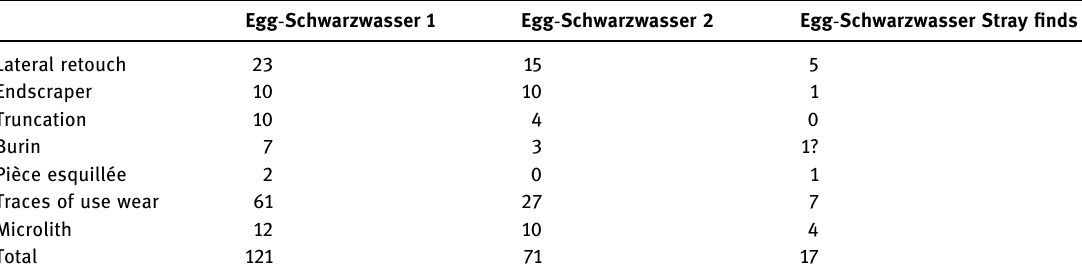
Table 2: Tool classes Egg - Schwarzwasser